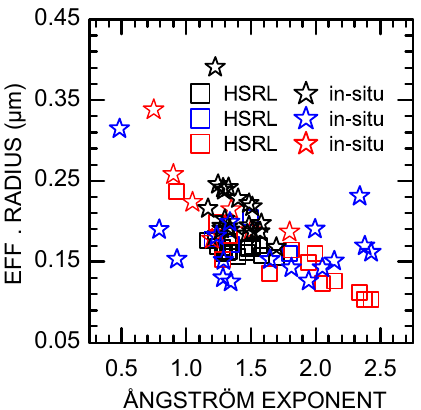
Figure 5. Correlation of Ångström exponents measured with HSRL-2 versus the effective radius (in µm) obtained from data in- version (boxes) and versus the effective radius measured in situ (open stars): 17 July (black), 22 July (red), and 25 July